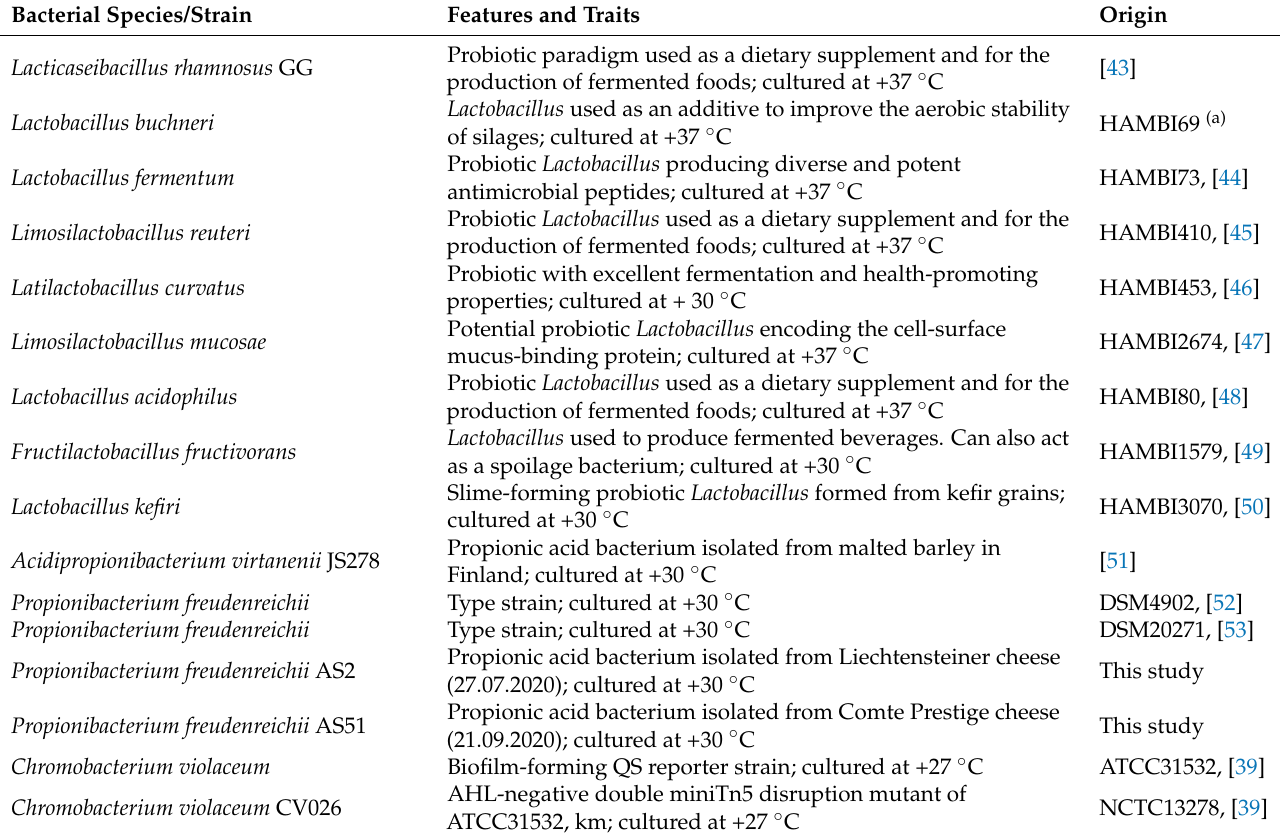
Table 1. Bacterial strains used to screen anti-QS and bactericidal